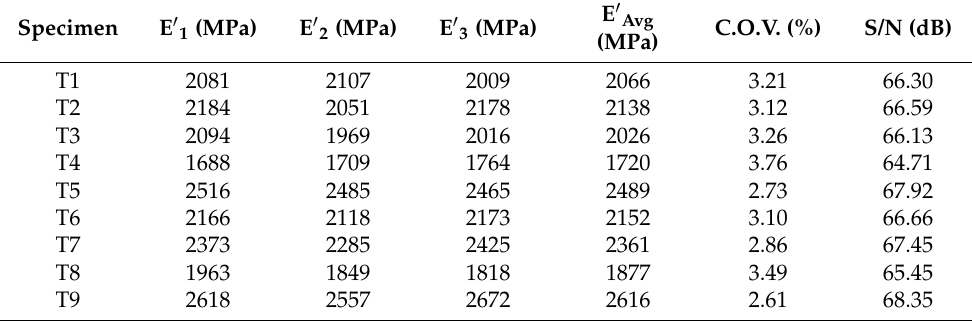
Table 6. Analysis on the measured results of the storage modulus at 30 ◦ C.